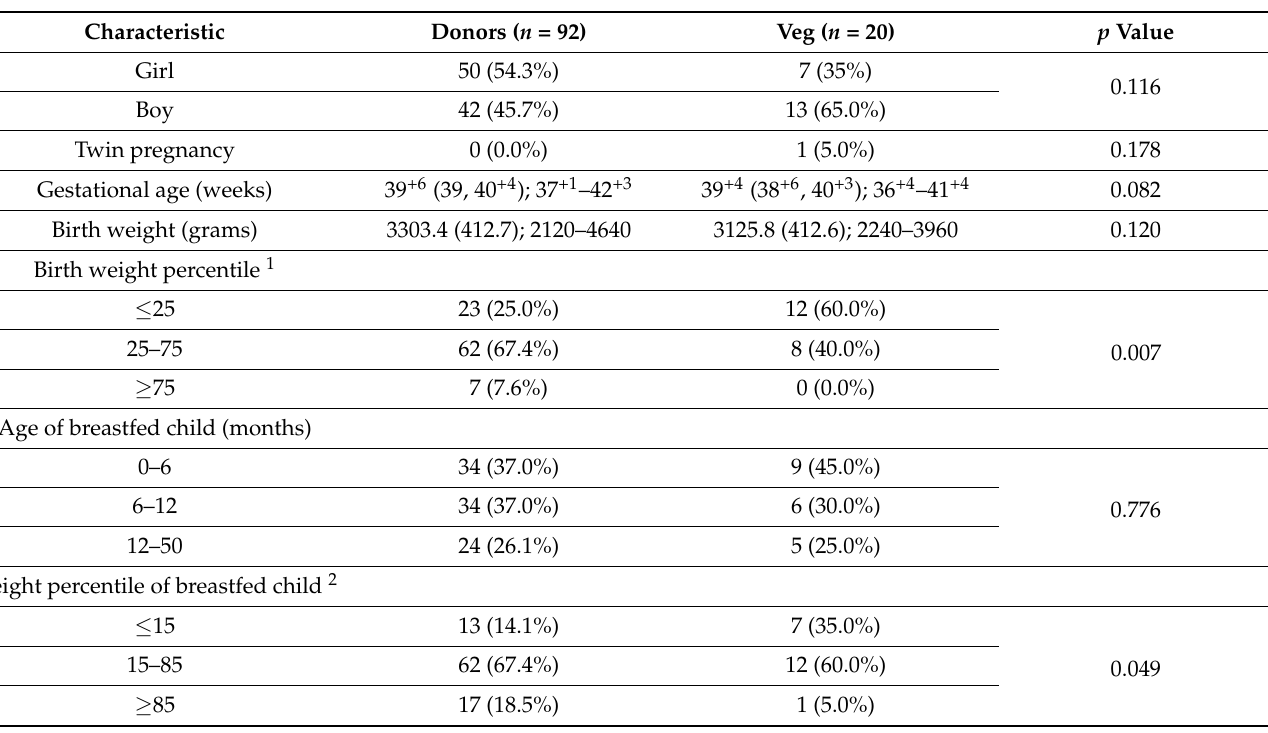
Table 2. Characteristics of the breastfed offspring of the omnivore human milk donors with full-term infants (Donors) and vegetarian/vegan lactating mothers (Veg).